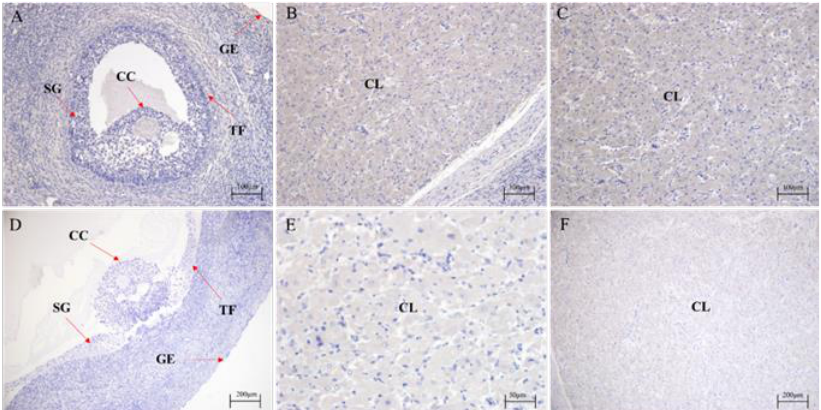
Figure 8. Localization of FAF1 protein expression in ovaries of different reproductive cycle phases. ( A – F ) Immunohistochemical staining. ( A – C ) Positive expression of FAF1. ( D – F ) Negative control of FAF1. ( A , D ) are follicular stage ovaries; ( B , E ) are luteal phase ovaries; ( C , F ) are ovaries during pregnancy; SG: granulosa cell; GE: germ epithelial cells; TF: follicle membrane cells; CL: luteal cells; CC: cumulus